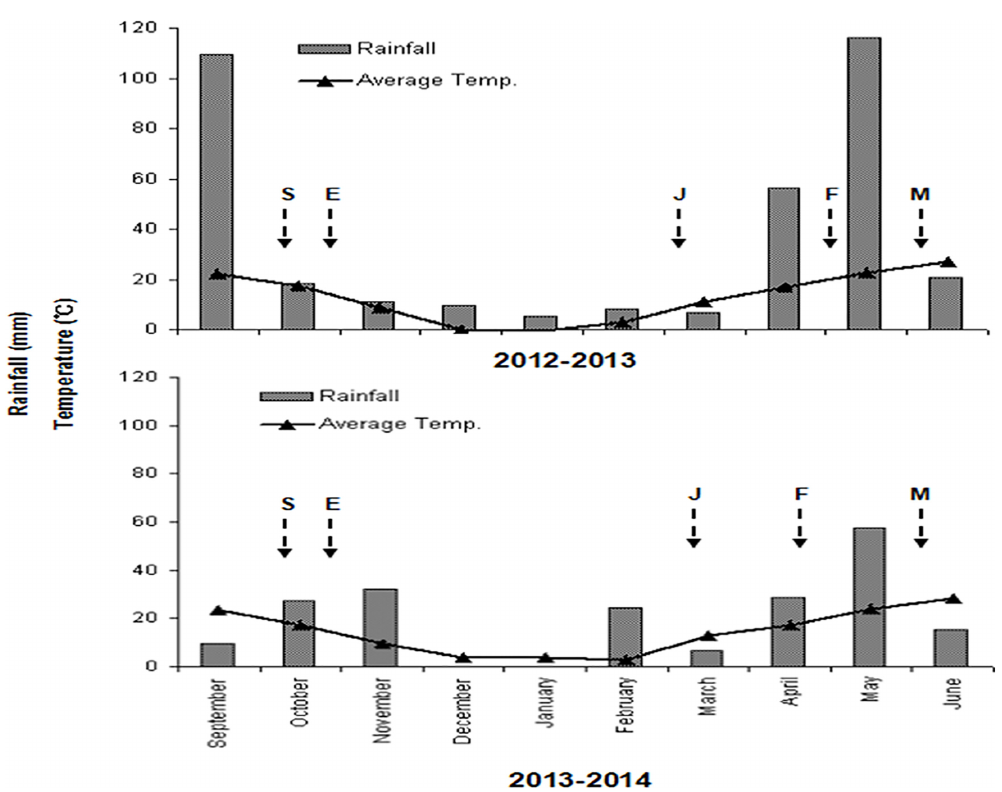
Fig 2. Accumulated rainfall (bars) and the mean temperatures (points and line) over the 2012 – 2013 and 2013 – 2014 wheat-growing periods at the experimental field (Zhengzhou, China). The arrows denote the dates: sowing stage (S), seeding emergence stage (E), jointing stage (J), anthesis stage (F), and maturity stage (M) for